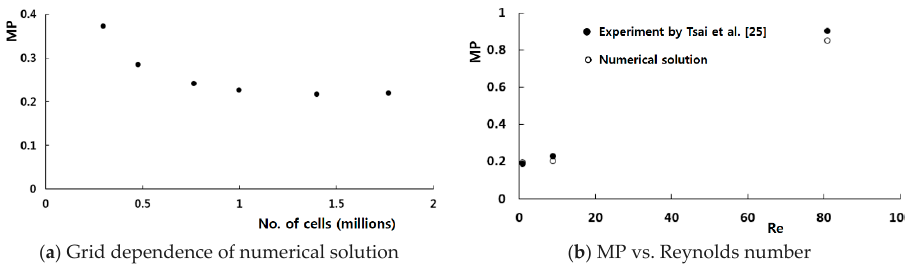
Figure 3. Validation of numerical solution. MP = Mixing performance.